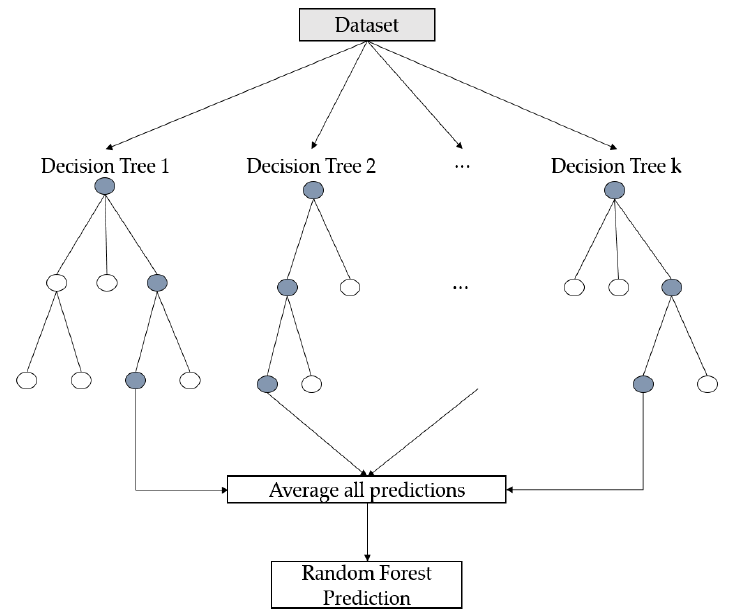
Figure 6. Example of the random forest with k decision trees.